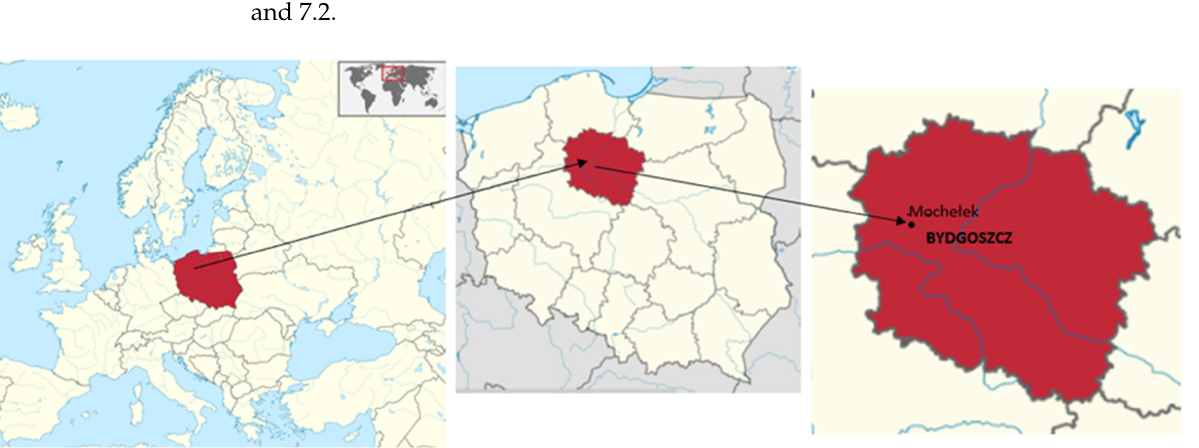
Figure 1. Site of field experiment at Mochełek, Kuyavian–Pomeranian voivodeship, Poland